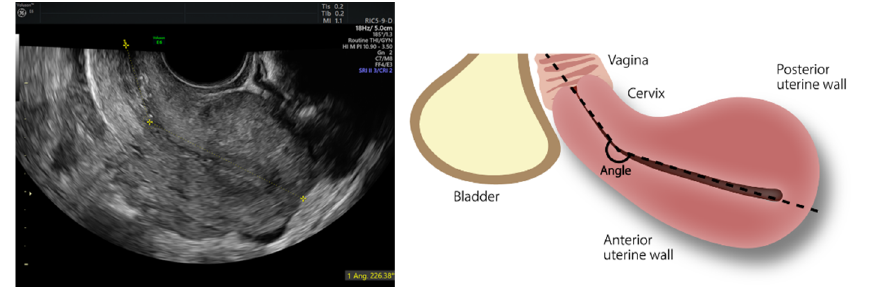
Figure 1. Ultrasonographic and schematic representation of angle of uterine flexion measurement. Ultrasound scans were performed by expert